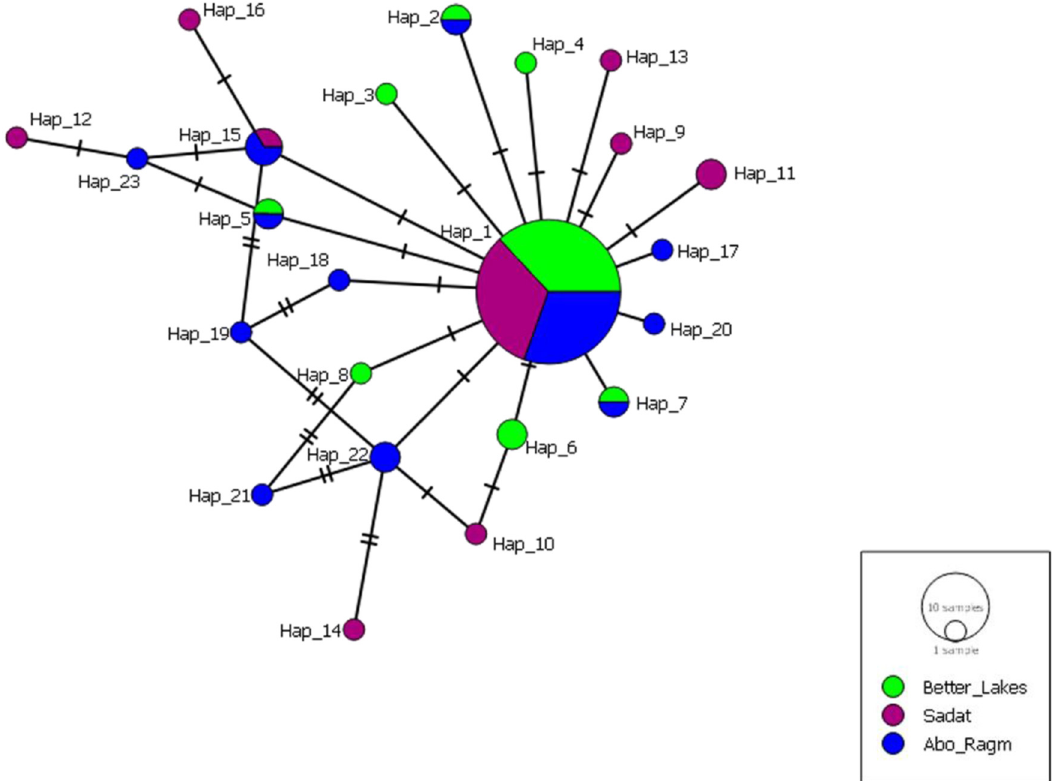
Fig. 4. Median-joining haplotype network for COI sequences in P. semisulcatus obtained from different areas in the North-West of the Red Sea. The branch length is proportional to the number of substitutions. Black transverse bars in the branches represent the polymorphic sites that differ among haplotypes. Circles represent haplotypes and their diameters are proportional to the haplotype frequencies. The Colour legend is shown on the down-right side of the